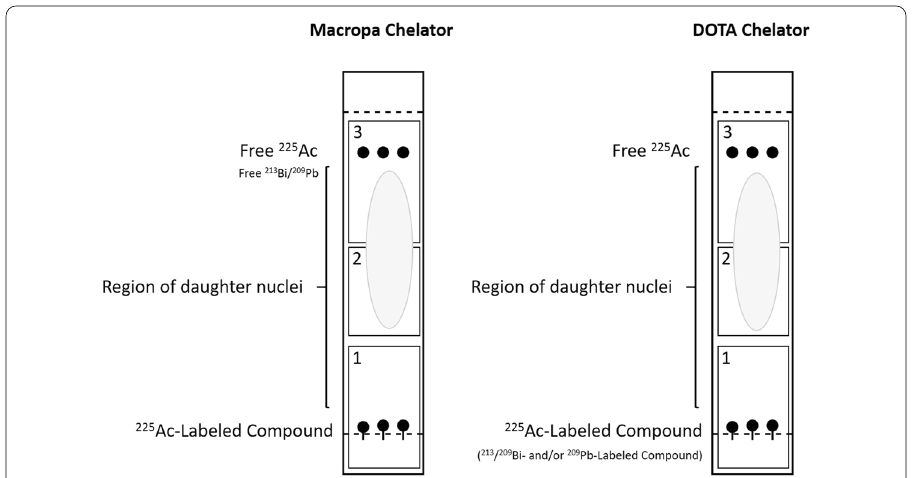
Fig. 4 Schematic of the distribution of radiolabeled compounds, unbound metal (transformed into the EDTA complex upon exposure to the mobile phase), and daughter nuclei ejected from the labeled compounds following radioactive decay during the TLC running period. The DOTA‑containing ligands are expected to chelate 209/213 Bi and 209 Pb in solution at 95 °C, but not to chelate daughter products generated by